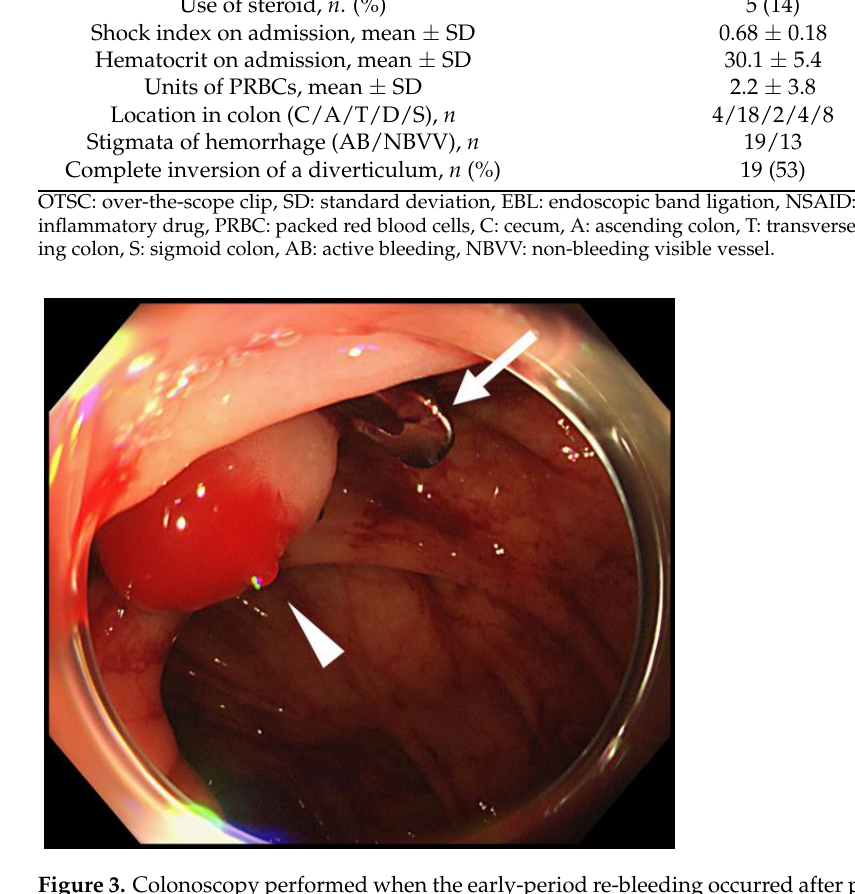
Figure 3. Colonoscopy performed when the early-period re-bleeding occurred after primary hemostasis by the OTSC method. Although an OTSC (white arrow) was still positioned and keeps the diverticulum inverted and bulged, active bleeding (white arrowhead) was observed from the top of the mound. Table 2. Treatment outcomes of the OTSC method for colonic diverticular